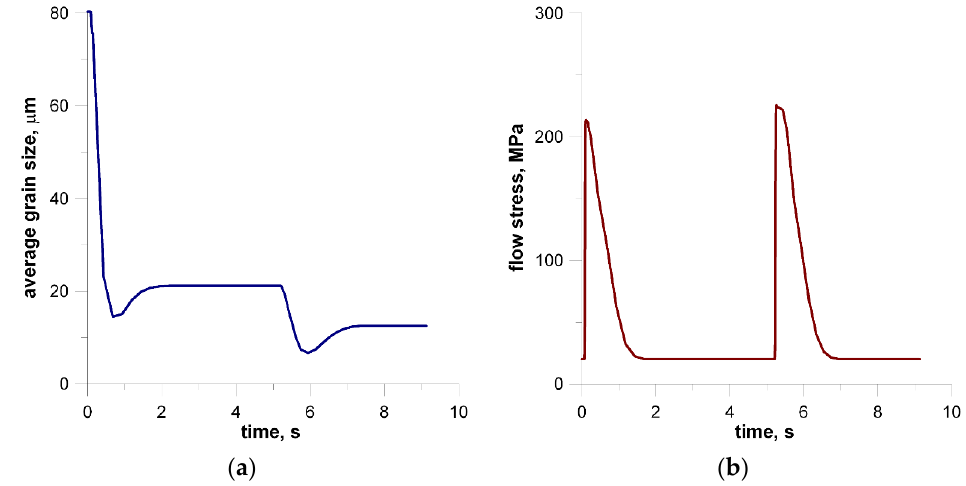
Figure 25. Microstructures: ( a ) initial, ( b ) before 2nd pass, ( c ) before 2nd pass and after straightening, ( d ) final microstructure, ( e ) final microstructure after straightening.